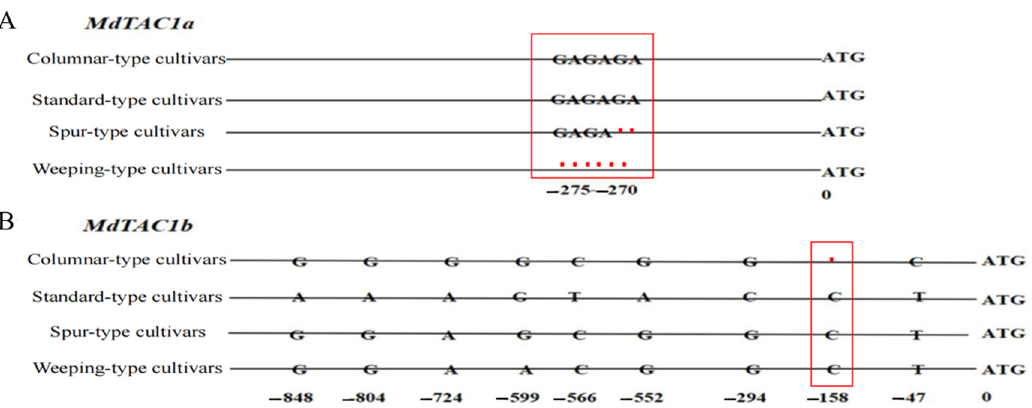
Figure 6. The Differences of MdTAC1a and MdTAC1b promoters among four apple cultivars. ( A ) The sequence of InDel in promoter regions of MdTAC1a in four-type cultivars. The initiation codon (ATG) A was defined as 0. The red box was a representation of the InDel area ( B ). The sequence SNPs in promoter regions of MdTAC1b in four-type cultivars.